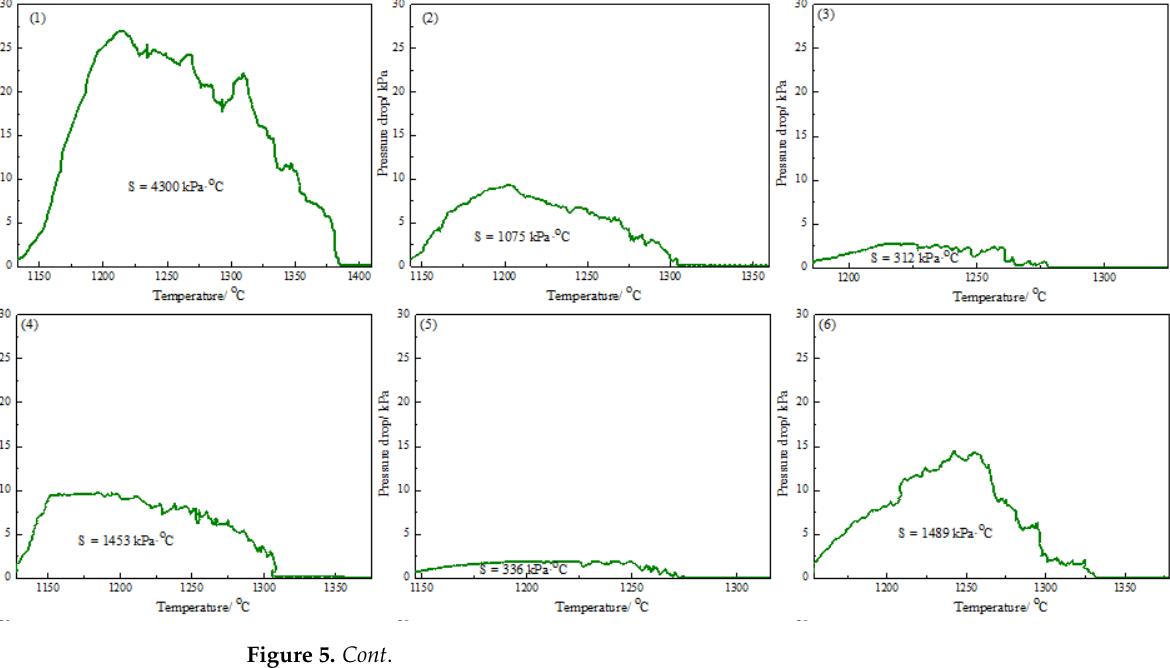
Figure 5. Characteristic number of gas permeability. According to the results of the maximum pressure difference value and gas perme- ability index of the ludwigite sinter, the influencing factors were analyzed by range, as shown in Table 14. Table 14. Range analysis of gas permeability index. Item